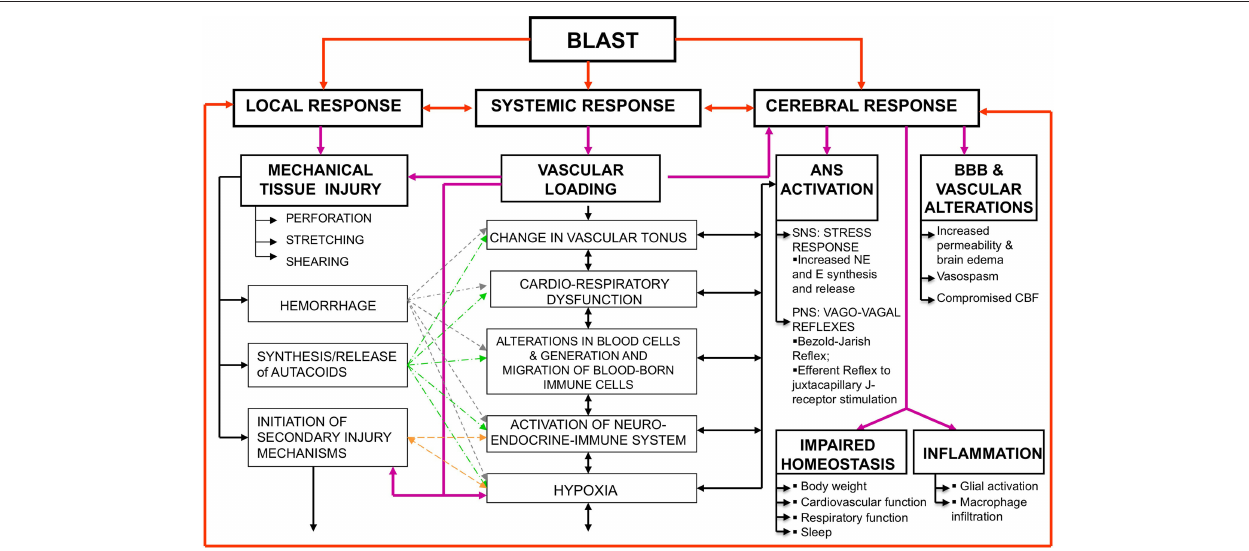
Figure 1 | Simultaneous activation of systemic, local, and cerebral responses to blast exposure, and interactive mechanisms causing or contributing to the pathobiology of BiNT. Abbreviations: ANS, autonomous nervous system; BBB, blood brain barrier; BINT, blast-induced neurotrauma; CBF, cerebral blood flow; E, epinephrine; NE, norepinephrine; SNS, sympathetic nervous system; PNS, parasympathetic nervous